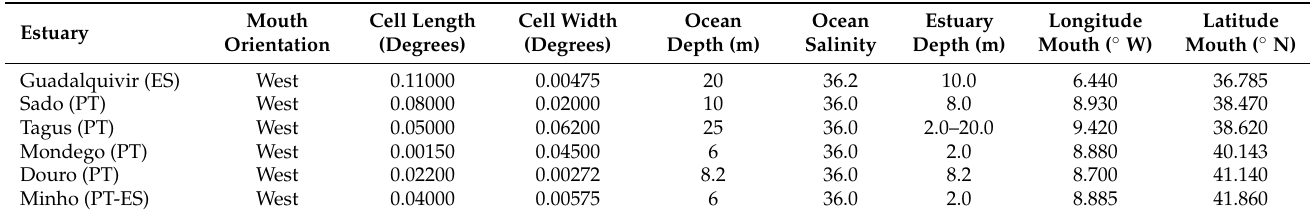
Table 1. Proxy configuration for the main six estuaries in western Iberia ordered from South to North. The Tagus estuary is the only proxy configured with variable depth along its